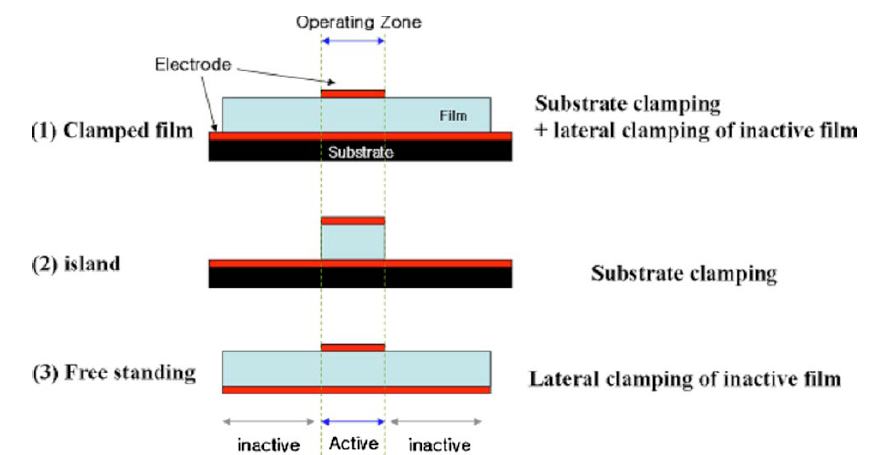
Figure 8. Schematic diagram illustrating two different types of clamping in fully-clamped, island, and freestanding films